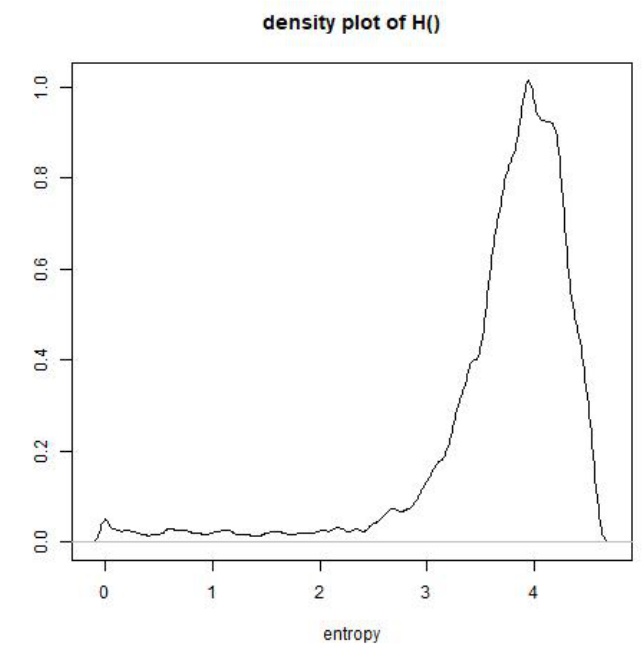
Figure A2. Density of the entropy H () over all 5541 BALDEY